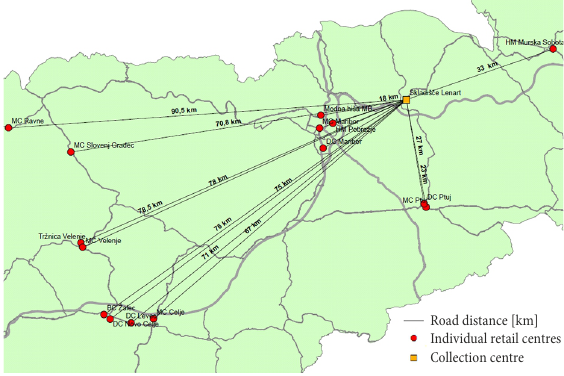
Figure 5. Current PW transportation system for PW removal